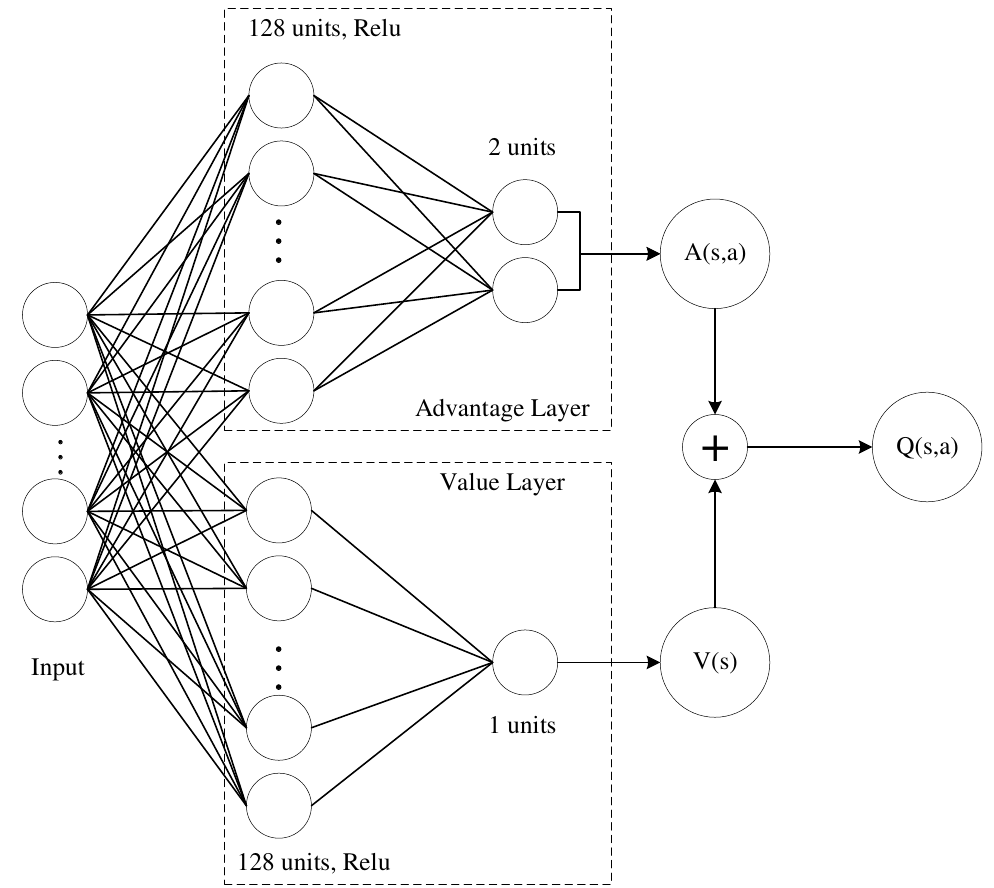
Figure 3. The neural network structure used in